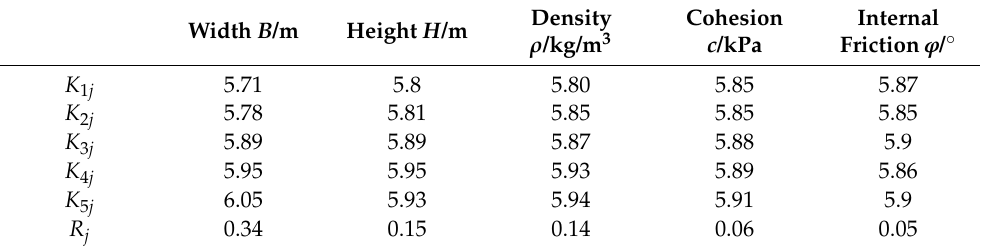
Table 6. Range analysis results.